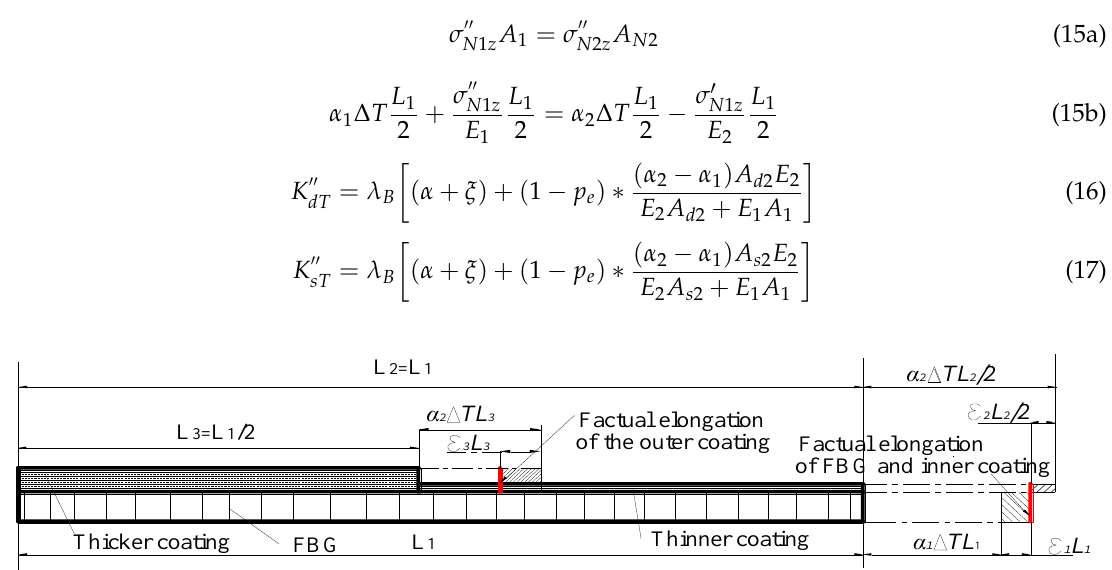
Figure 9. Diagram of the thermal strains of the Type C SMC-FBG.